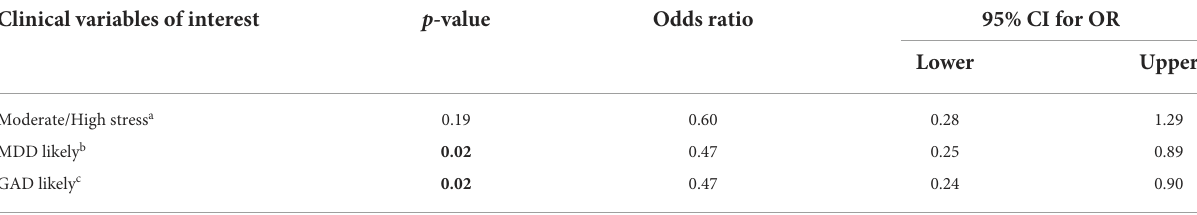
TABLE 4 Odds for subscribers in the IG to have various clinical characteristics compared to the CG. Clinical variables of